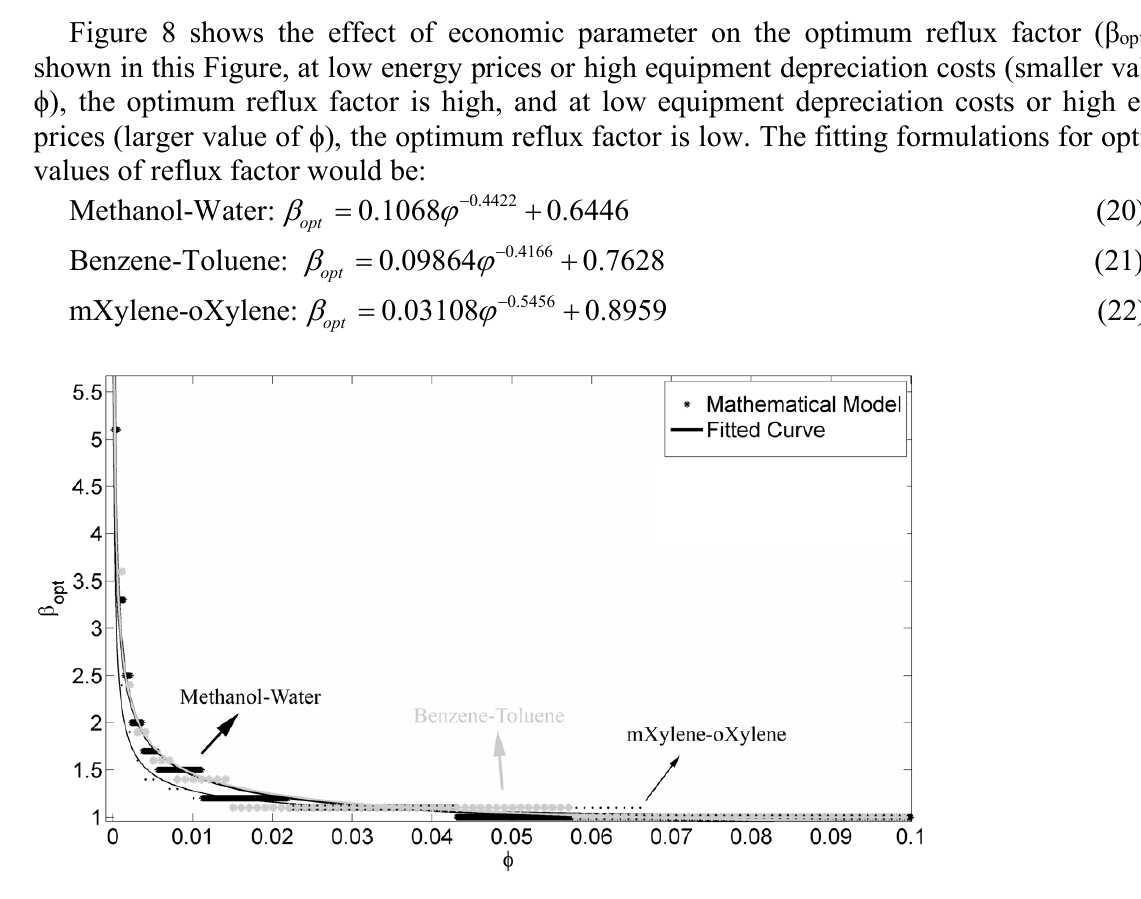
Figure 8. Effect of economic parameter ( ϕ ) on the optimum reflux factor ( β